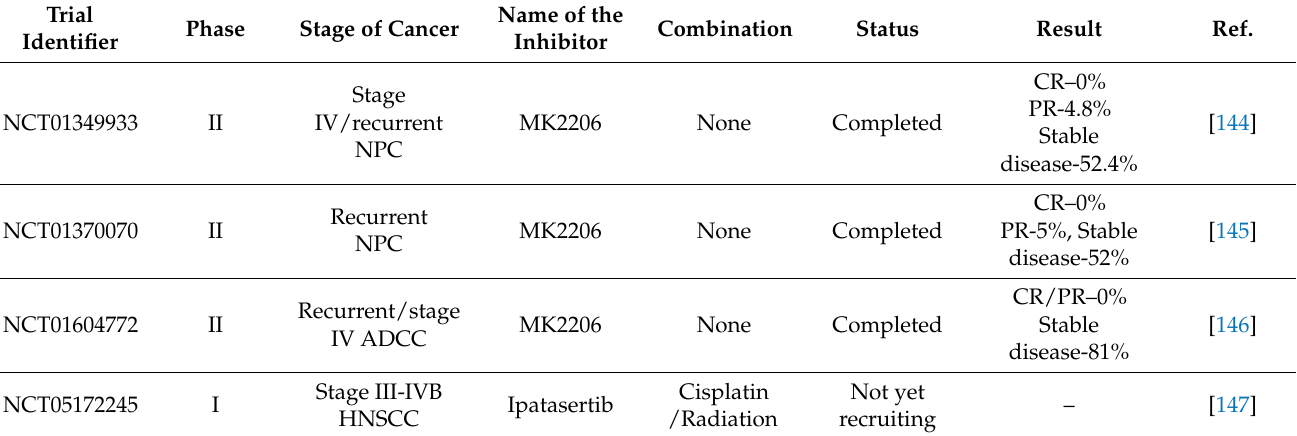
Table 1. Recent clinical trials of Akt inhibitors in HNSCC patients. CR—complete response; PR—p- artial response; NPC—nasopharyngeal cancer; HNSCC—head and neck squamous cell arcinoma; ADCC—adenoid cystic